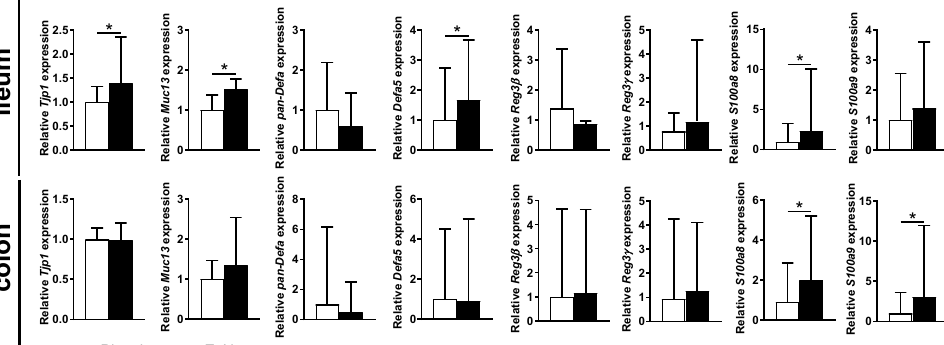
Figure 7. Live EcN increases the expression of some anti-microbial peptides in the gut at day 28 post-induction. Data are pooled from 5 independent experiments (in total: n = 25 (placebo) or 27 (EcN)) and differences were quantified by unpaired Mann–Whitney test; * p < 0.05.